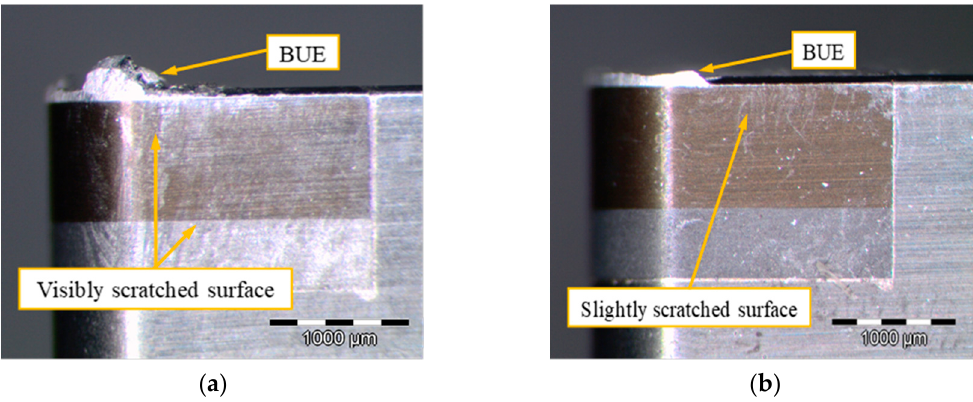
Figure 14. Inserts used in the machining trials ( a ) large built-up-edge (BUE) and noticeable scratches in the insert without chip breaker and ( b ) small BUE and minor scratches in the insert with chip breaker.